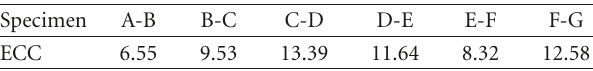
Table 2: Gage factors of ECC based on 4-point DC probe